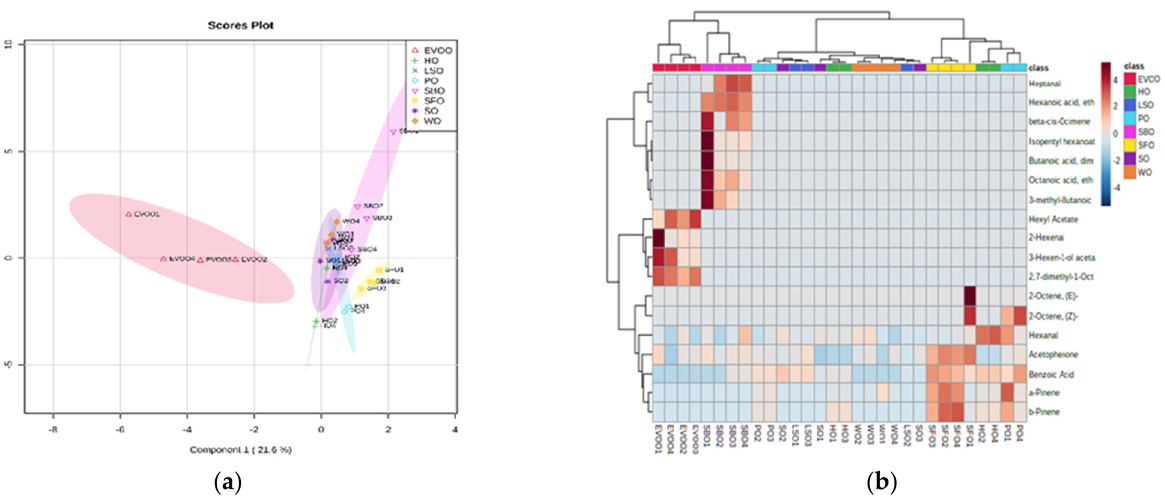
Figure 2. ( a ) PLSDA score plot for the discriminatory analysis of the eight classes of oils, based on ITEX/GC-MS analysis of volatiles. ( b ) Heatmap illustrating the volatile biomarkers of each individ- ual